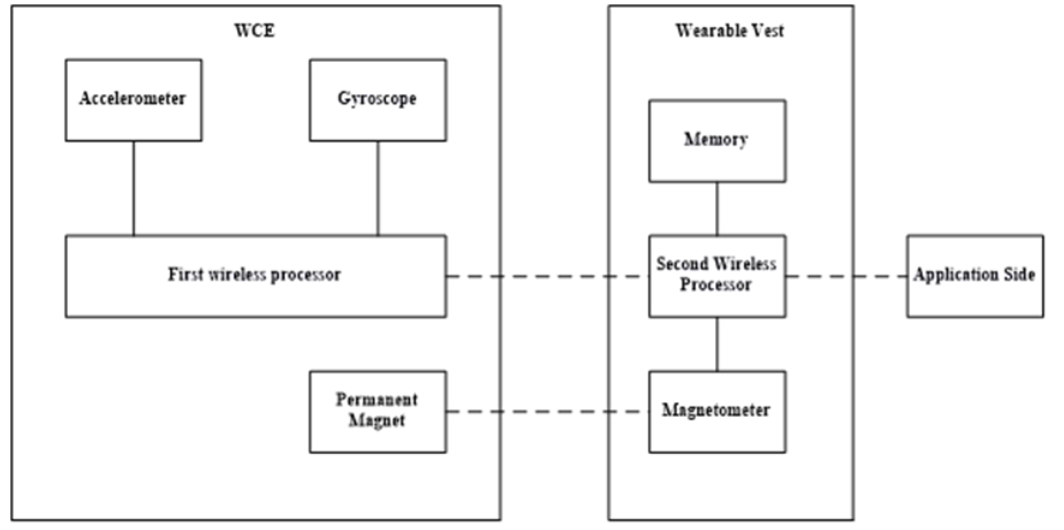
Figure 8. IMU-magnetic sensor fusion